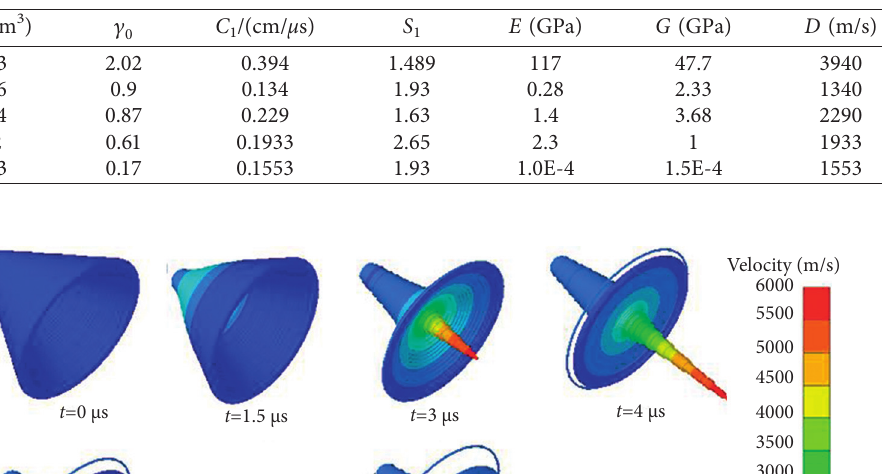
Table 2: Main material parameters of liner and gelatin target.